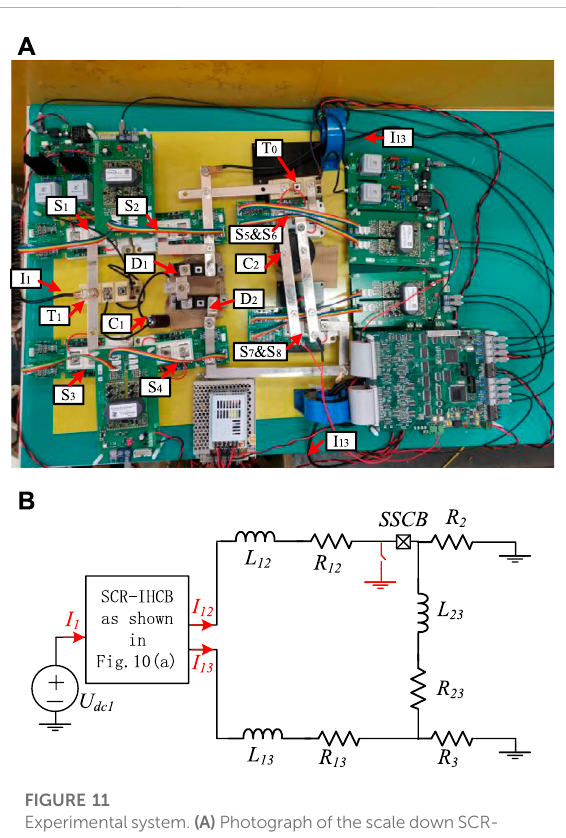
FIGURE 11 Experimentalsystem. (A) Photograph ofthescale down SCR- IHCB prototype. (B) Circuit diagram of three-terminal test platform.